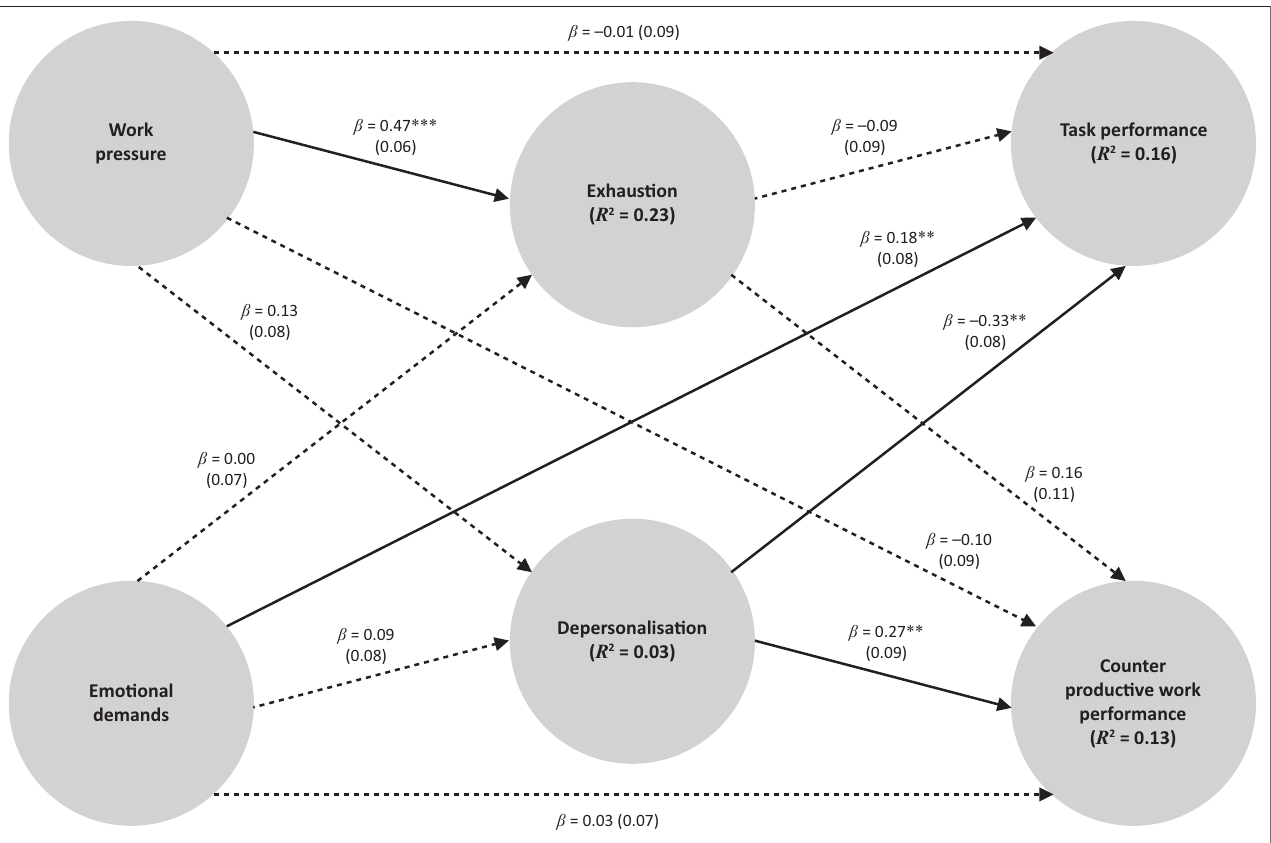
FIGURE 1 : Structural model of demands, ill-being and performance (dashed lines indicate non-significant regression